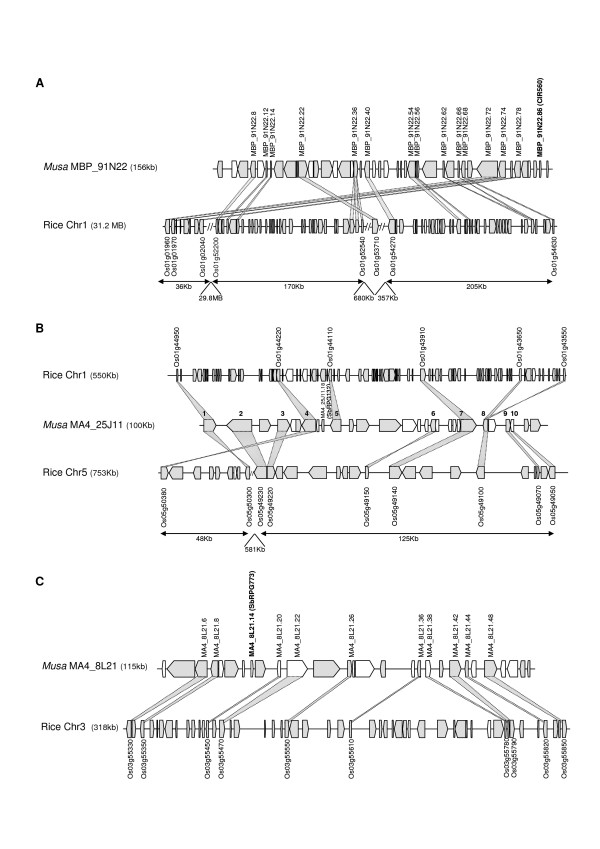
Musa-rice syntenic regions. Predicted genes and their orientation are shown as boxed areas. Genes annotated such as hypothetical genes are represented in white. The probes used to identify the Musa BAC clones are indicated in brackets. Conserved genes between Musa and rice regions are connected by shaded areas. (A) Syntenic relationship between Musa MBP_91N22 BAC clone and rice chromosome 1. (B) Syntenic relationship between Musa MA4_25J11 BAC clone and rice chromosome 1 and 5. The numbers above the genes correspond to the locus numbers used for phylogenetic analyses. (C) Syntenic relationship between Musa MA4_8L21 BAC clone and rice chromosome 3.